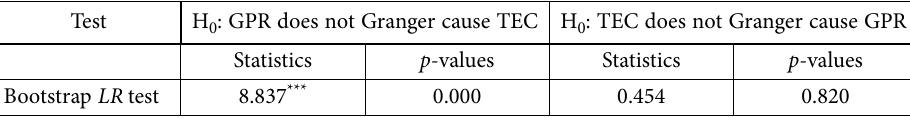
Table 3. The full sample Granger causality test Test